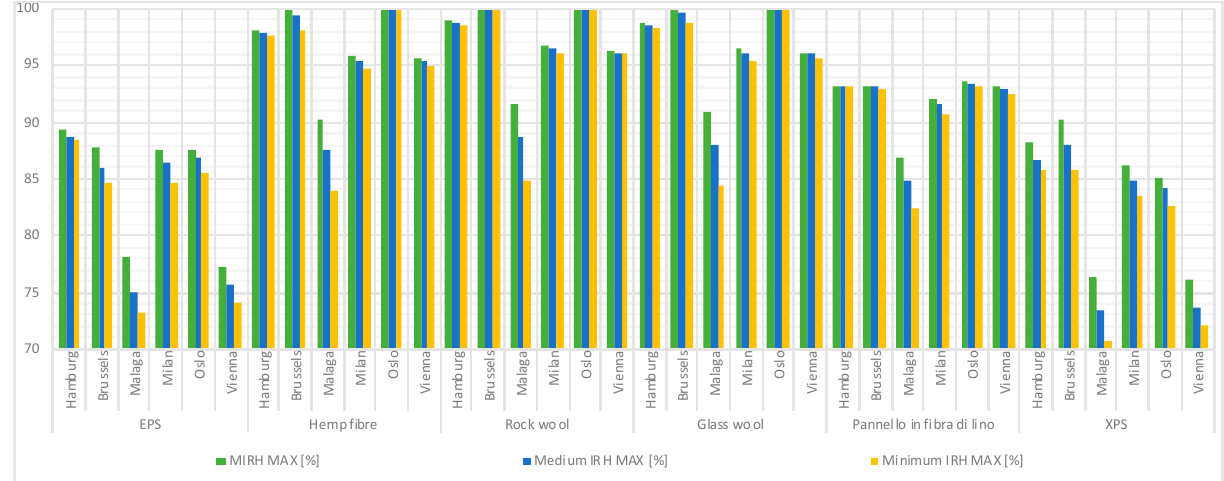
Figure 4. Results of maximum, average, and minimum IRH values (%), broken down by insulation type and application scenario.